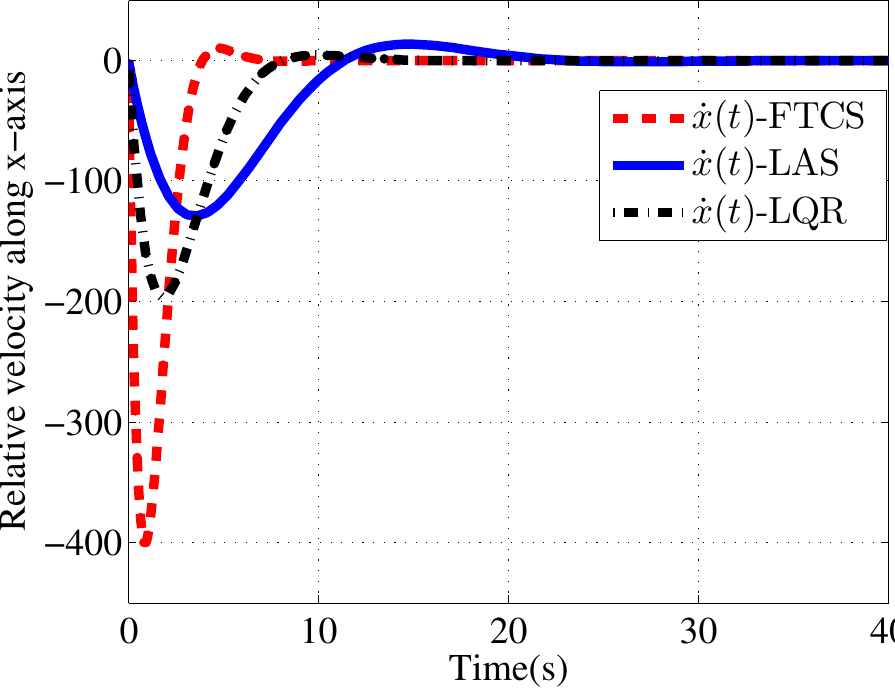
Figure 6. Relative velocity along x -axis under different control